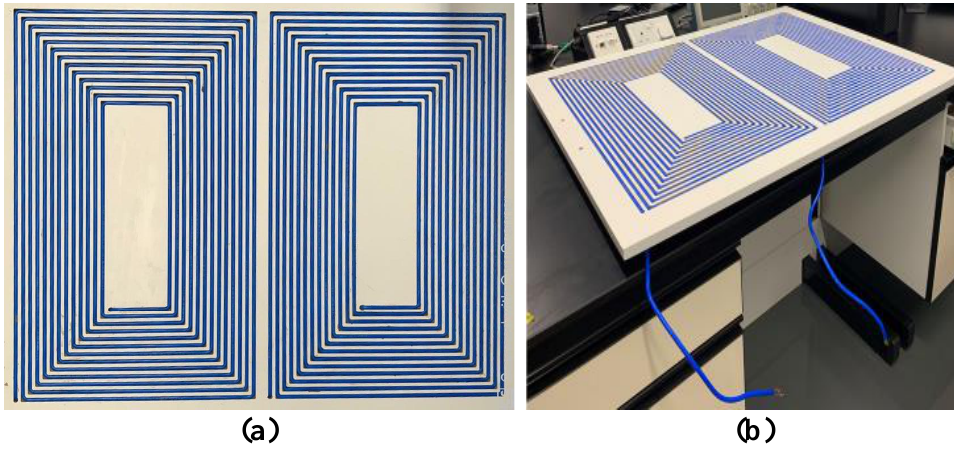
Figure 12. 13-turn DD coil prototype, ( a ) top-view, ( b ) side-view showing coil terminals.